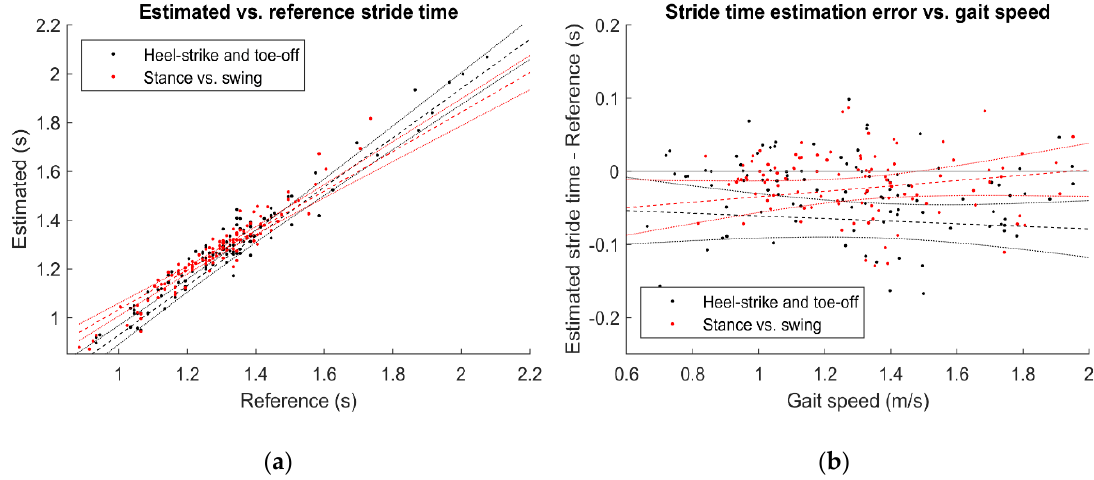
Figure 7. Regression plots comparing estimated and reference stride time ( a ) and the measurement error as a function of gait speed ( b ). Regression lines (dashed) and 95% confidence bounds (solid lines) were reported.